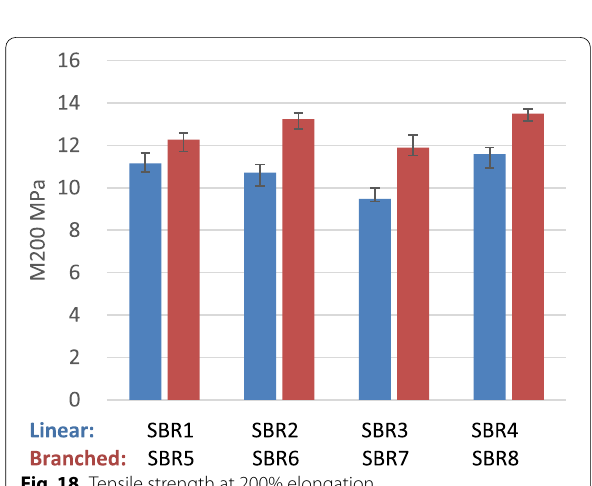
Fig. 18 Tensile strength at 200%